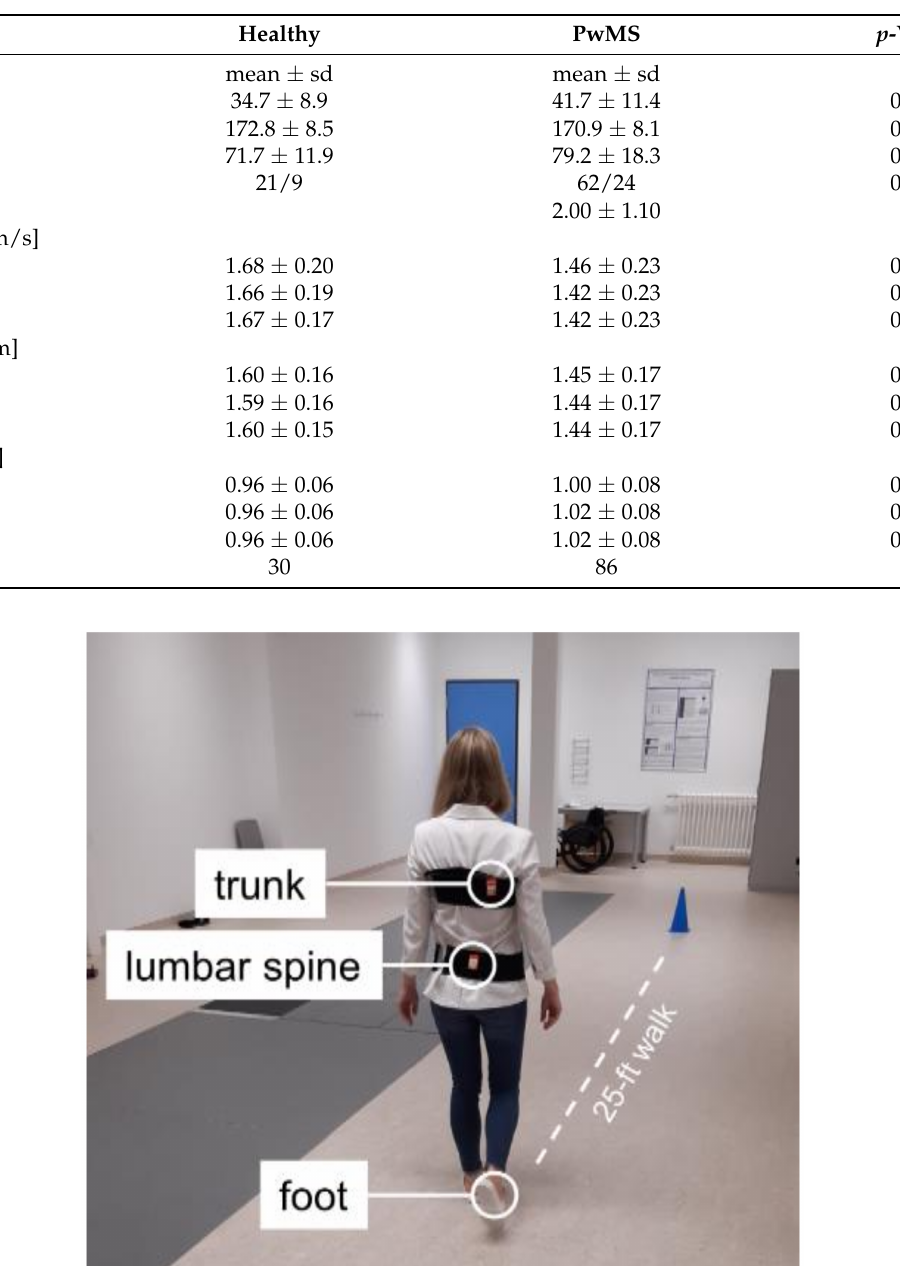
Table 1. Participants’ demographics, Expanded Disability Status Scale (EDSS, range: 0–5) and spatiotemporal measures of gait (walking speed, stride length, stride time).